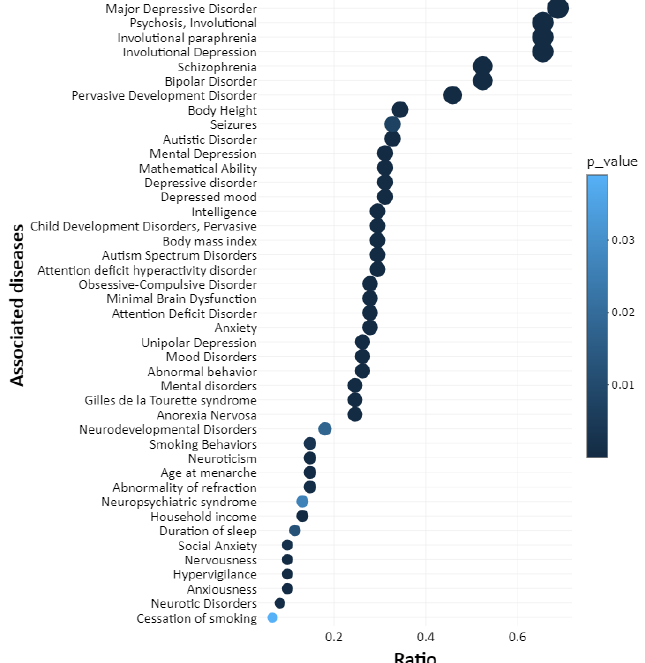
Figure 2. pGenes are associated with mental disorders. Result of the disease enrichment analysis. The ratio corresponds to the number of pGenes associated with each disease relative to all pGenes. Dot size is proportional to the number of pGenes associated with each disease. Gene enrichment